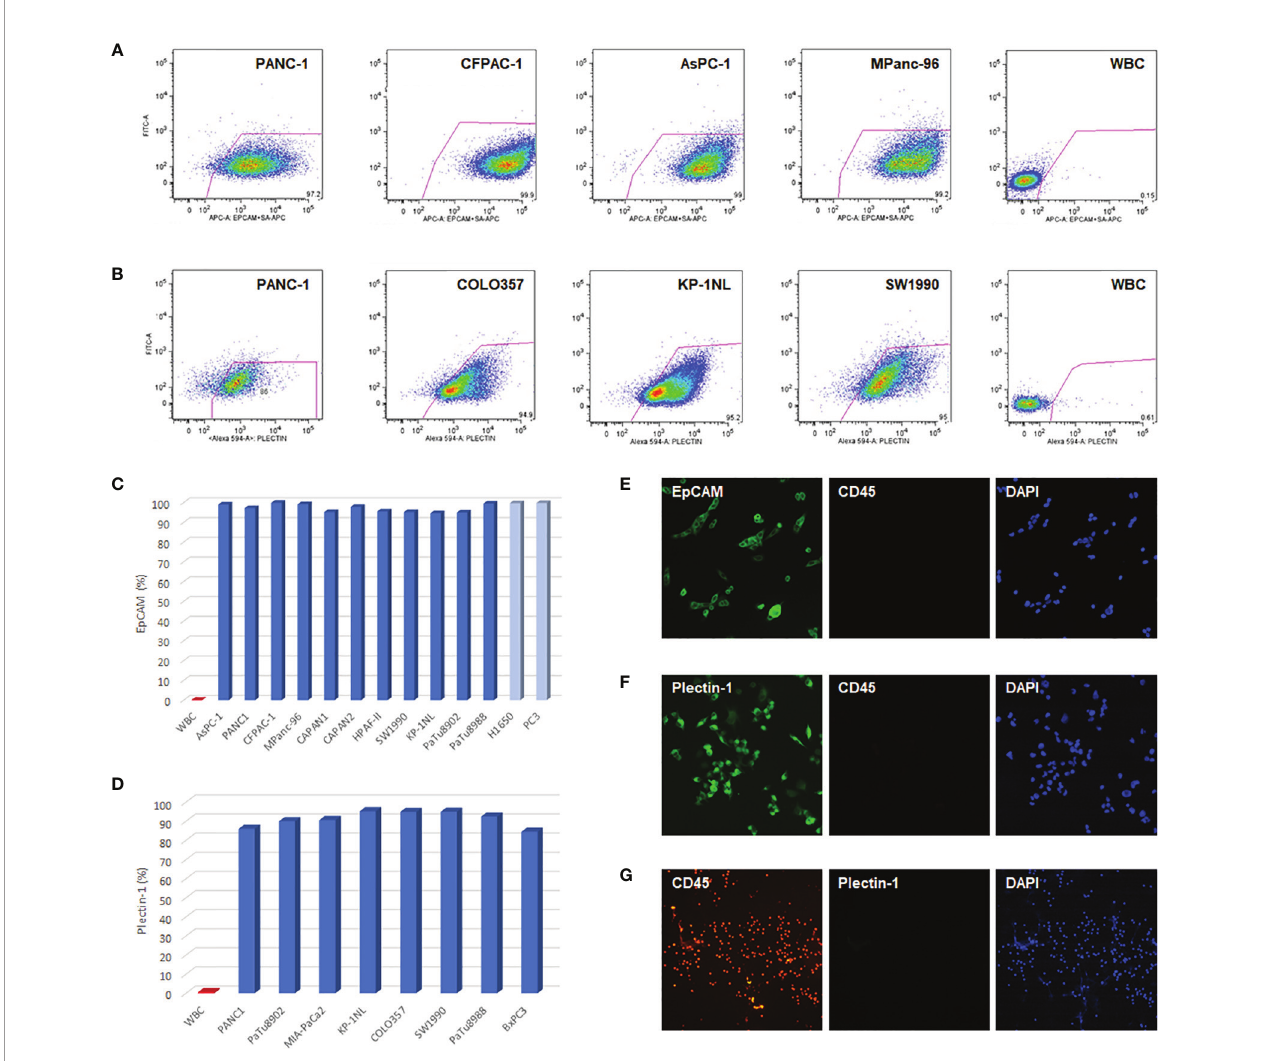
FIGURE 1 | EpCAM and Plectin-1 expression in PDAC cells. To evaluate the anti-EpCAM and anti-Plectin-1 antibodies for detecting CTCs, the expression of EpCAM and Plectin-1 antigen was examined in PDAC cell lines by fl ow cytometry. (A) The surface expression of EpCAM in PDAC cell lines (PANC-1, CFPAC-1, AsPC-1, MPanc-96). (B) The expression of Plectin-1 in PDAC cell lines (PANC-1, COLO357, KP-1NL, SW1990). The expression of (C) EpCAM and (D) Plectin-1 in various PDAC cell lines were represented as percentages. WBCs were used as negative controls. To examine the expression of EpCAM and Plectin-1, (E) CAPAN-1 cells were stained with EpCAM (green) and CD45 (red), (F) MIA-PaCa2 cells were stained with Plectin-1 (green) and CD45 (red), and (G) WBCs were stained with CD45 (red) and Plectin-1 (green). All nucleated cells were stained with DAPI